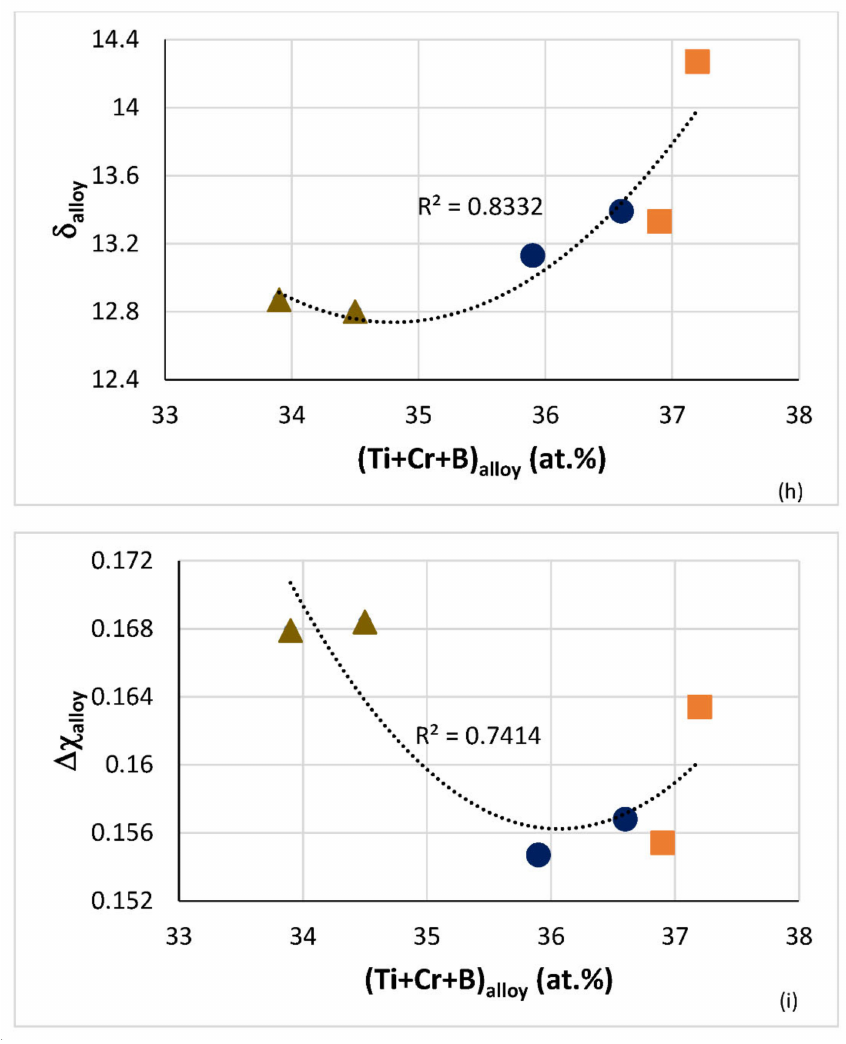
Figure 9. Maps of the parameters VEC alloy , δ alloy and ∆ χ alloy with sums or ratios of Ti, Cr or B in AC and HT alloys TT2, TT4, TT8 and “equivalent” B free alloys KZ4, KZ5 and JG3. R 2 values for linear or parabolic fit of data. ( a ) VEC alloy versus (Ti + Cr) alloy , ( b ) δ alloy versus (Ti + Cr) alloy , ( c ) ∆ χ alloy versus (Ti + Cr) alloy , ( d ) VEC versus Ti/Cr, ( e ) δ versus Ti/Cr, ( f ) ∆ χ versus Ti/Cr, ( g ) VEC versus Ti + Cr + B, ( h ) δ versus Ti + Cr + B and (( i ) ∆ χ versus Ti + Cr + B. ( a ) to ( f ) data for the alloys TT2, KZ4, TT4, KZ5, TT8 and JG3, ( g ) to ( i ) data for the alloys TT2, TT4, TT8. ( a , b , d , e ) colours as follows: green for TT2 and KZ4, purple for TT4 and KZ5, and blue for TT8 and JG3. ( g ) to ( i ) triangles for TT8, squares for TT4, and circles for TT2. ( c ) and ( f ) green colour for all alloys. In ( a ) to ( f ) diamonds for B containing